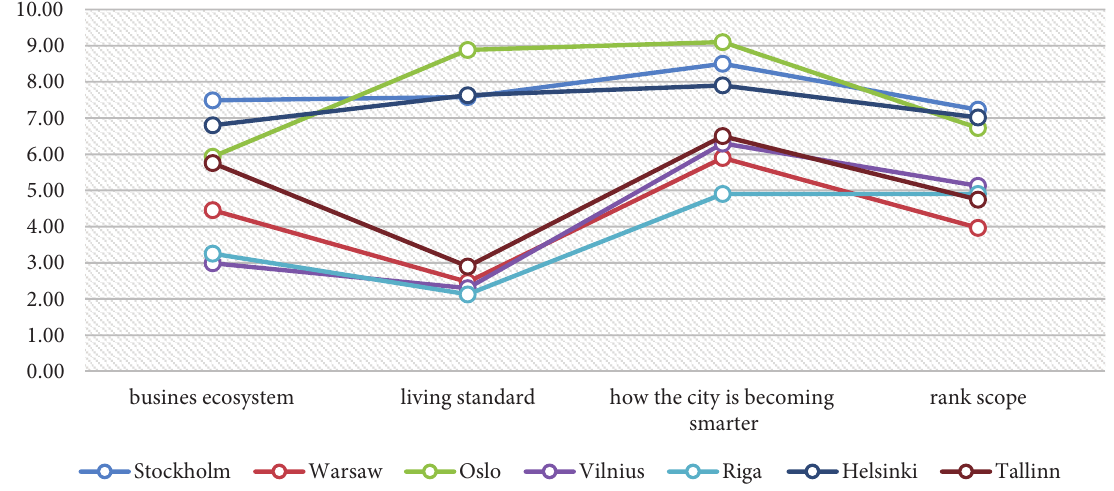
Figure 2. 7 Baltic region cities smartness